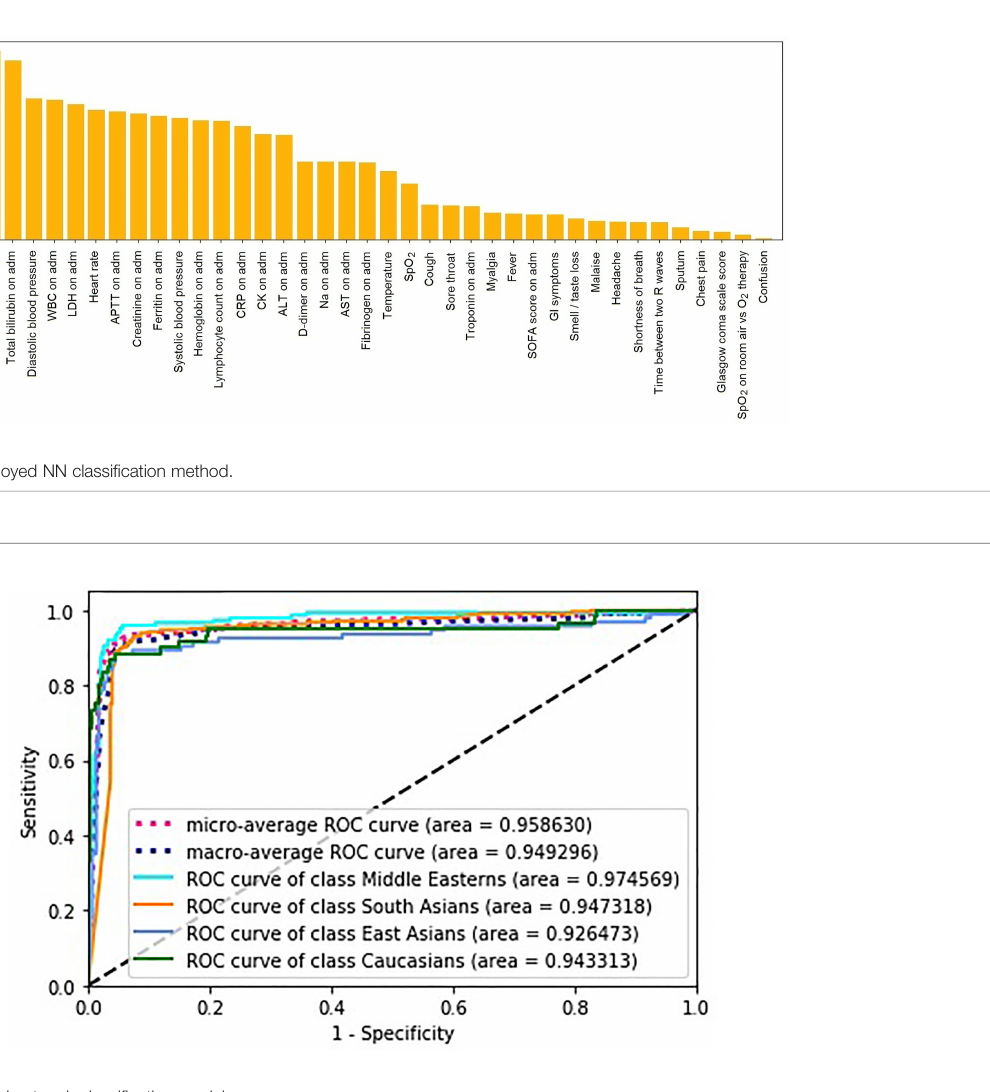
FIGURE 5 | Performance of neural network classi fi cation